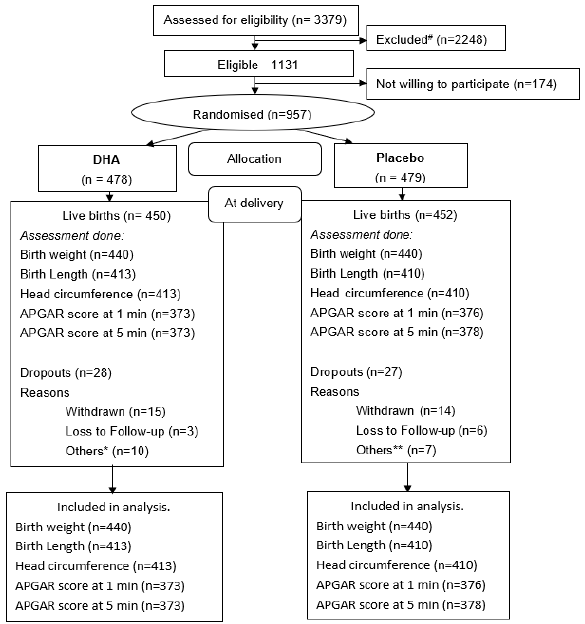
Figure 1. Consort # reasons for exclusion: gestational diabetes ( n = 69); Hb < 7 g% ( n = 46); gestational age > 20 weeks ( n = 673); high risk pregnancies ( n = 118); chronic conditions ( n = 246); under any other trial ( n = 4); delivery plan other than PK ( n = 835); missing/wrong contact information ( n = 257). * Others included abortion ( n = 1); abruptio placenta ( n = 1); fresh still birth ( n = 4); macerated still birth ( n = 3); neonatal death ( n = 1) in DHA group. ** Others included fresh still birth ( n = 4); macerated still birth ( n = 2); medical termination ( n = 1) in placebo